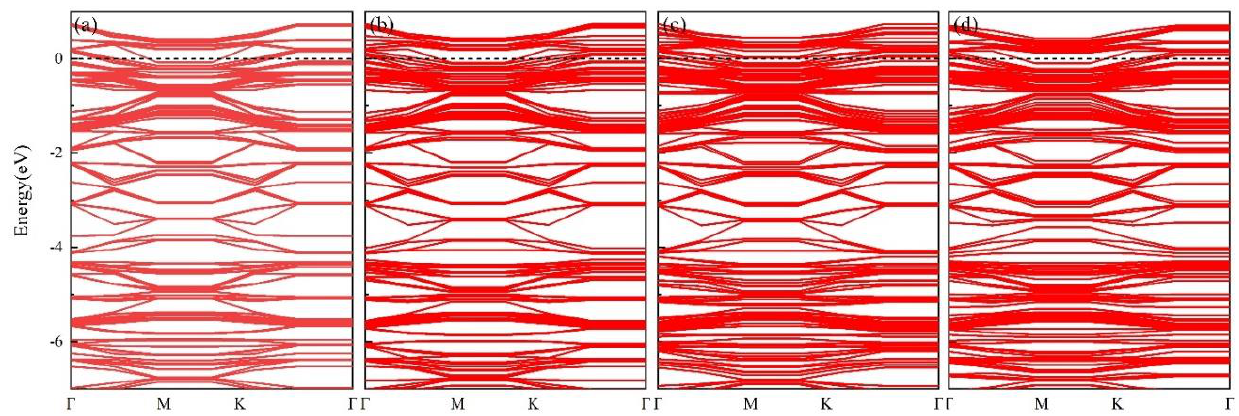
Figure 4. Band structures of H 2 S ( a ), SO 2 ( b ), SOF 2 ( c ) and SO 2 F 2 ( d ) systems. The dash line is the Fermi level.